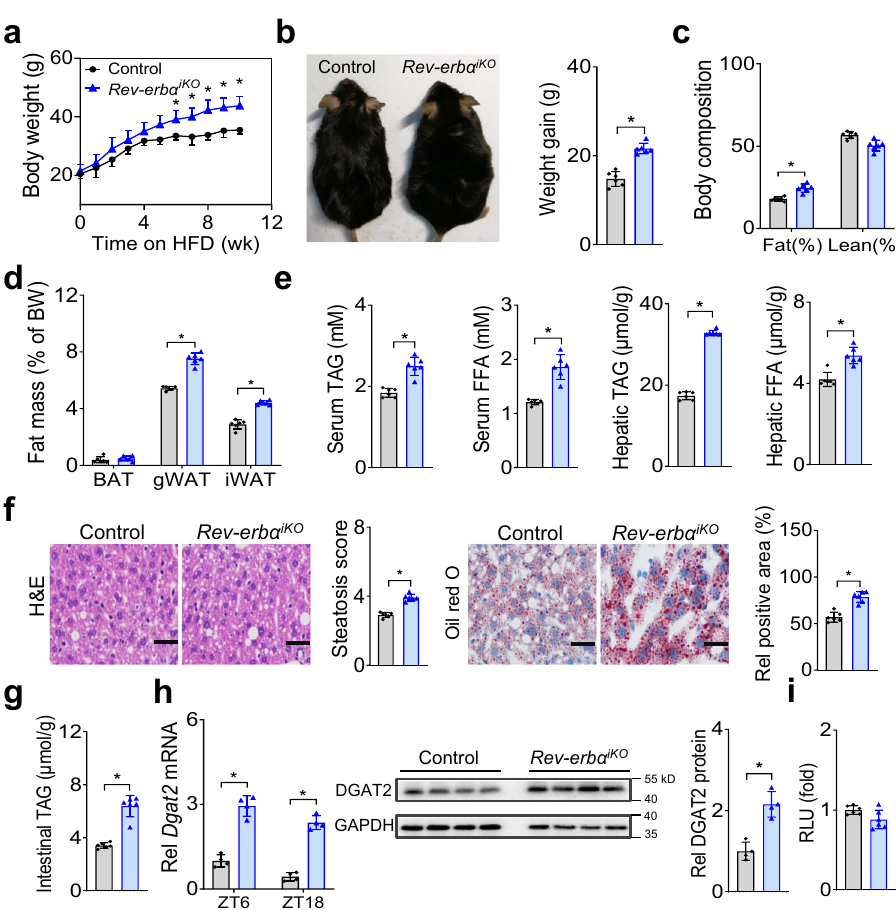
Fig. 7 Intestinal de fi ciency of the BMAL1 repressor Rev-erb α promotes HFD-induced obesity. a Body weight curves of Rev-erb α iKO and control mice